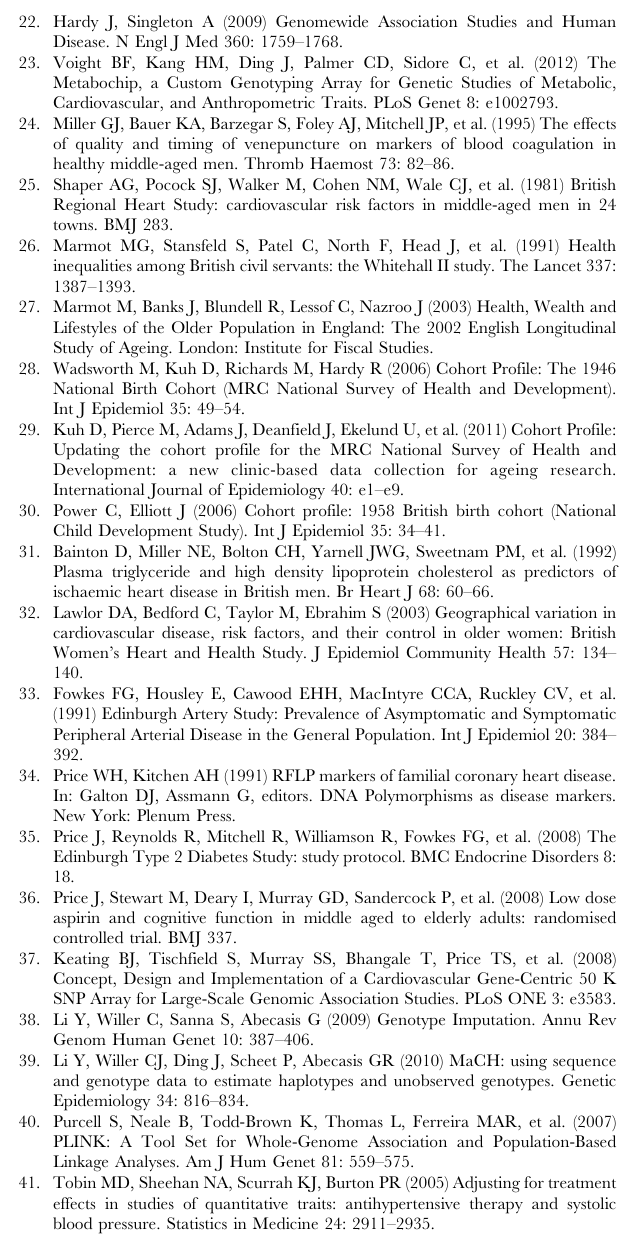
Table S1 Table S1a: Power for discovery for quantitative traits. Table S1b: Power for translation for quantitative traits (DOCX) Table S2 Table S2a: Power for discovery for common alleles. Table S2b: Power for translation for common alleles. Table S2c: Power for discovery for rare alleles. Table S2d: Power for translation for rare